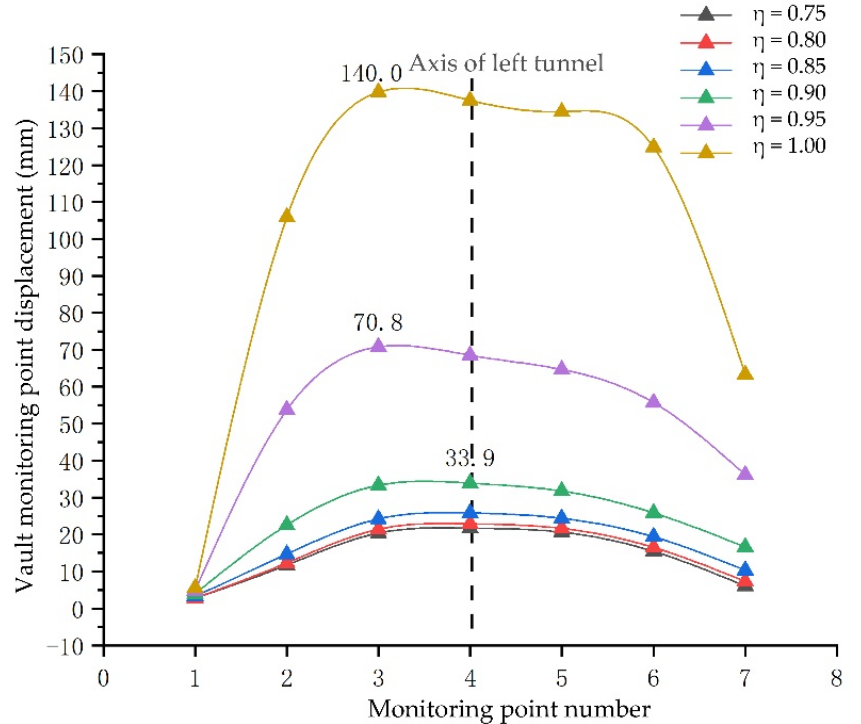
Figure 21. Displacement of monitoring points near the vault of left tunnel. Figure 22 shows the relationship between the maximum displacement of monitoring points on the vault and the water–cement ratio. When the slurry water–cement ratio η = 0.75, 0.80, 0.85, 0.90, 0.95, and 1.00, the maximum displacements of the vault were 21.7 mm, 22.9 mm, 25.8 mm, 33.9 mm, 70.8 mm, and 139.8 mm, respectively. Compared with the simulation results of the previous water–cement ratio condition, the variation range of the maximum displacement of the vault was 1.2 mm, 2.9 mm, 8.1 mm, 36.9 mm, and 69 mm. With the increase of water–cement ratio, the maximum displacement of the vault increased and the increasing range was also increased, indicating that when the water cement ratio was large ( η = 0.85, 0.90, 0.95, 1.00), reducing the slurry water–cement ratio obtained obvious reinforcement effects. When the slurry water–cement ratio was 0.80 or 0.85, the maximum displacement of vault caused by excavation was small and the reduction range was large, and the reinforcement effect was better and the benefit was